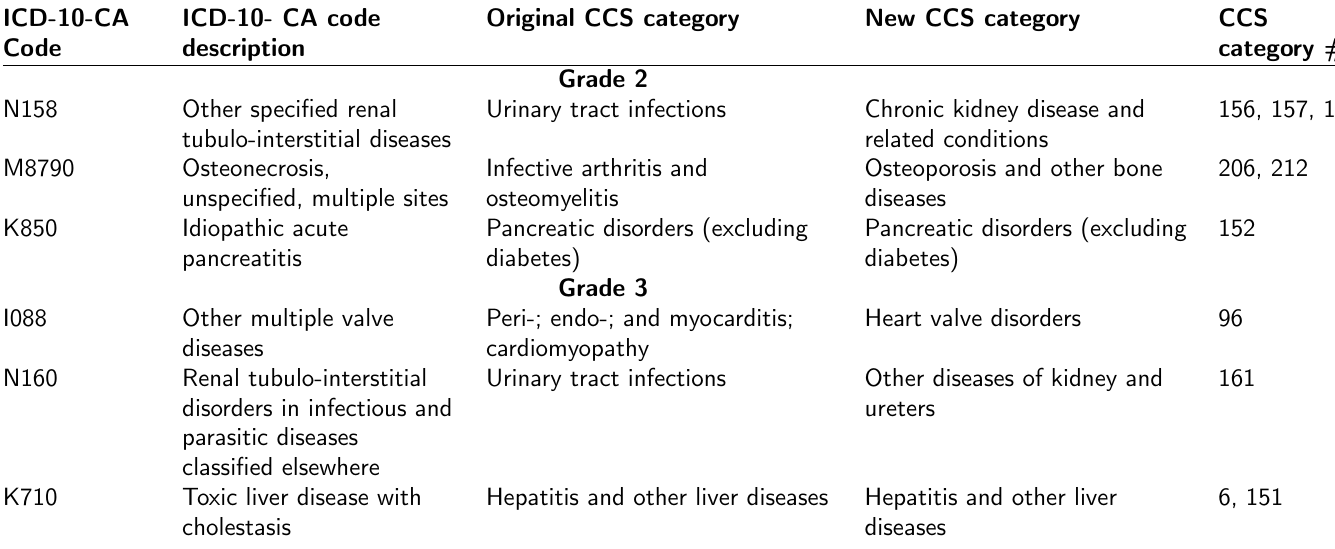
Table 3: Examples of ICD-10-CA codes that were graded 2 or 3 and final mapping